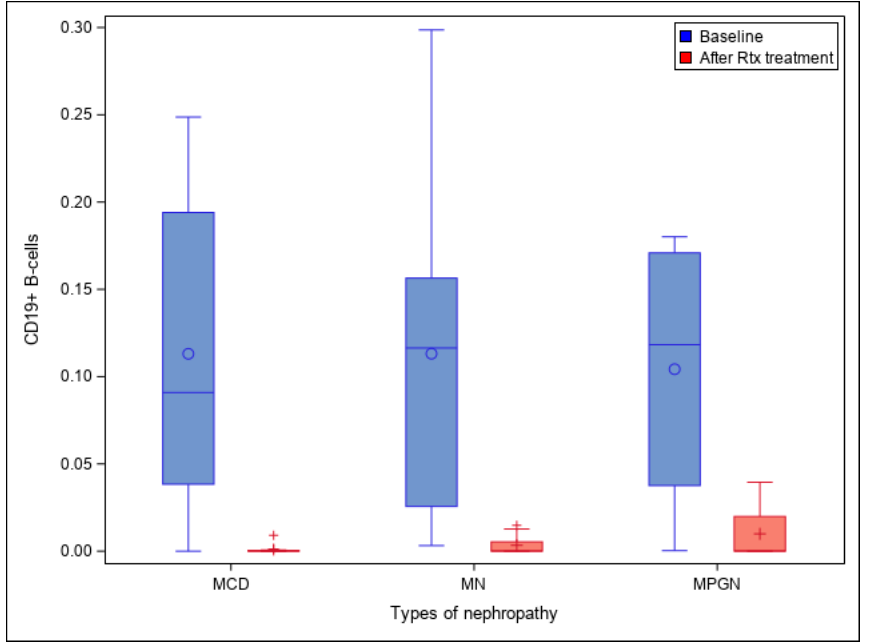
Figure 1. CD19+ B cell values before and after rituximab (RTX) for each of the three main types of nephropathy (MN, MCD, and MPGN). MN: membranous nephropathy. MPGN: membranoproliferative glomerulonephritis. MCD: minimal change disease. Rtx: rituximab.